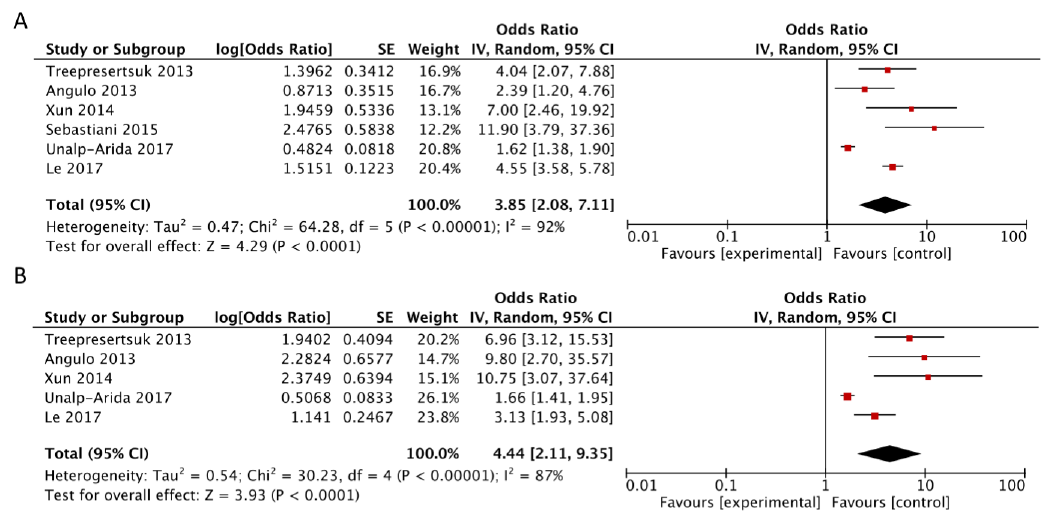
Figure 2. Forest plot of summary relative risks (RRs) of mortality ( A ) for high versus low–intermediate NAFLD fibrosis score, and ( B ) for high versus low NAFLD fibrosis score.